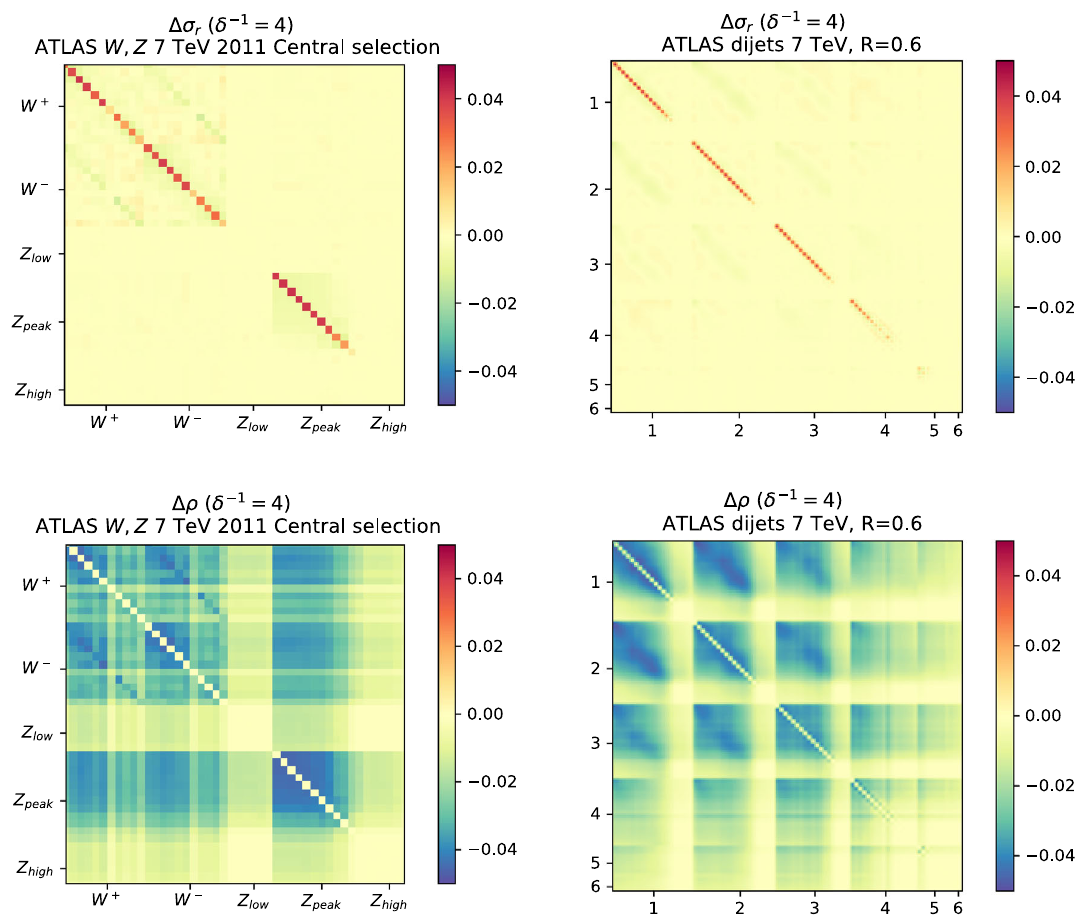
Fig. 3 The relative difference of the covariance matrix (cid:6)σ r (top) and the difference of the correlation matrix (cid:6)ρ (bottom) for each of their elements, computed between the regularised data sets and the data set nominalwith δ − 1 = 4.Weshowresultsforthetwomeasurementsinthe NNPDF4.0datasetthathavethelargestvalueof Z ,seeTable1:ATLAS W , Z 7 TeV CC [15] (left) and ATLAS dijets R=0.6 7 TeV [24] (right).